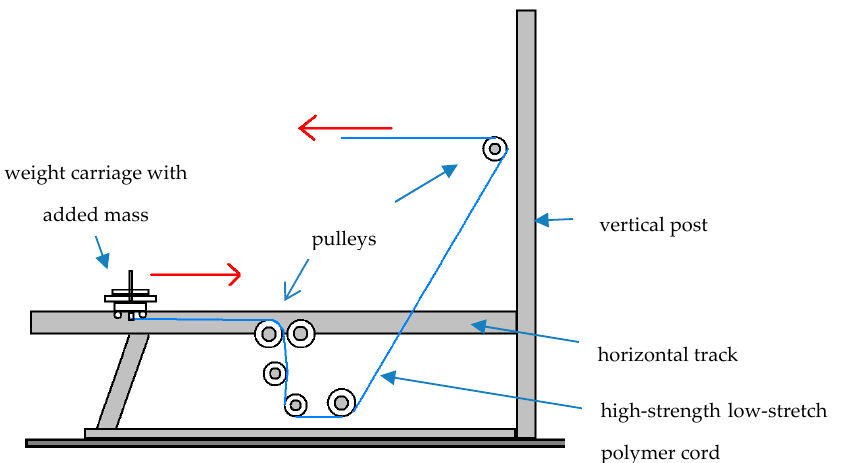
Figure 1. Side view illustration of the inertial exercise trainer (IET; Impulse Technologies; Newnan, GA, USA).